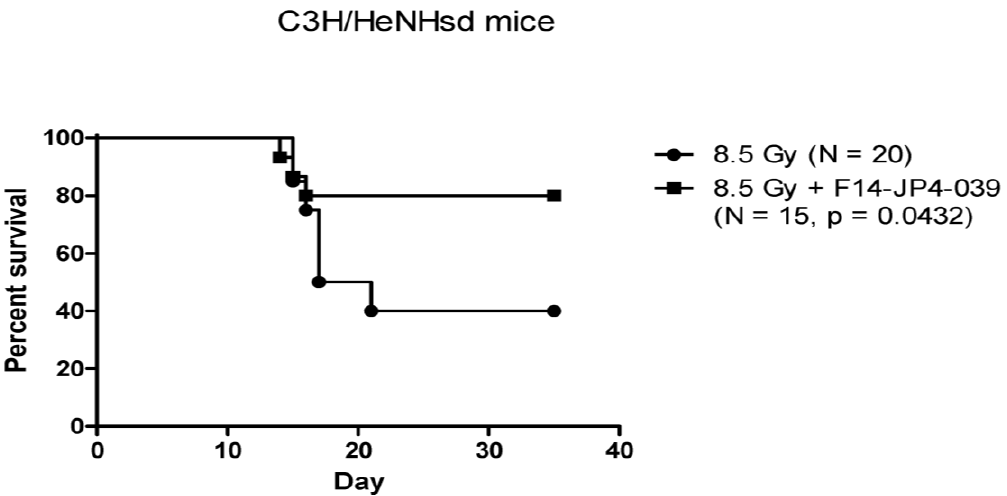
Figure 4. Mitigation of total body irradiation damage to C3H/HeNHsd mice by intravenous JP4-039/F14 antioxidant small molecule therapy. Groups of C3H/HeNHsd mice ( n = 15) received total body irradiation, and 24 h later intravenous administration of 100 μL of F14 liposomes containing 100 μg of JP4-039. Survival was quantitated, and there was a significant increase in survival in mice given